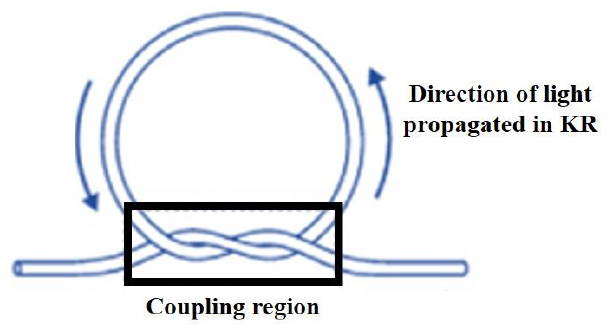
Figure 19. Modified technique to manufacture the KR.